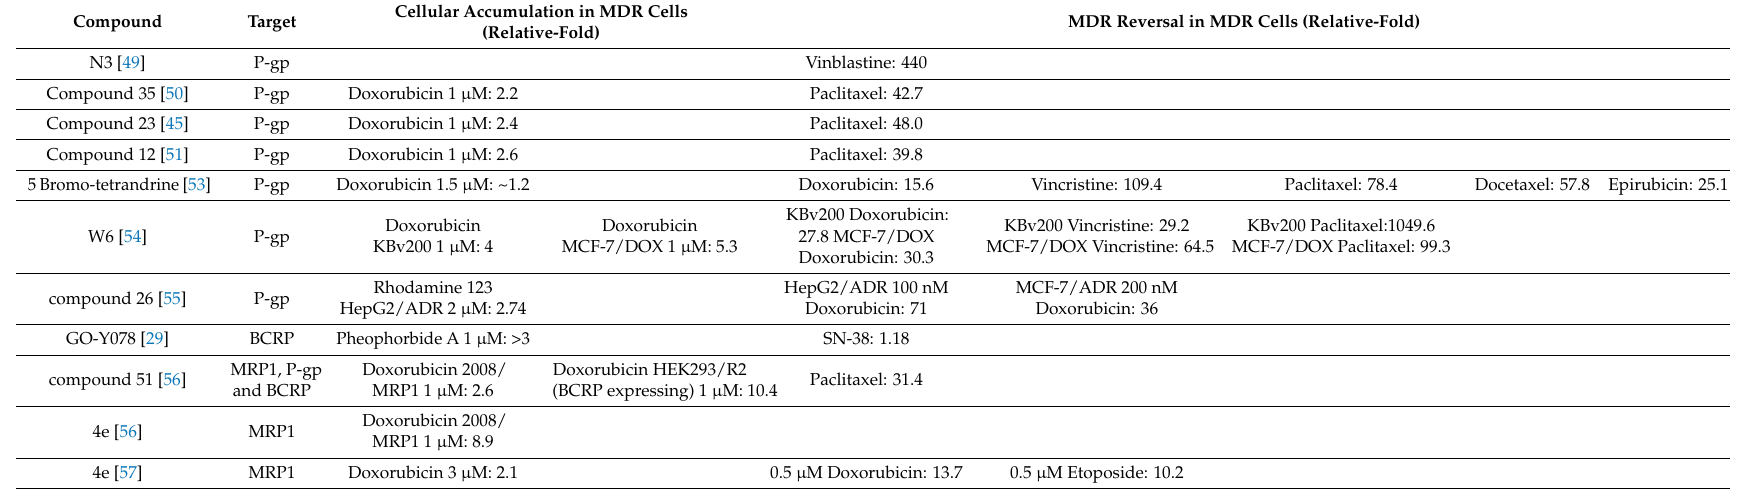
Table 2. Effects of the potent synthetic modulators on cellular accumulation and cytotoxicity of substrates of ABC